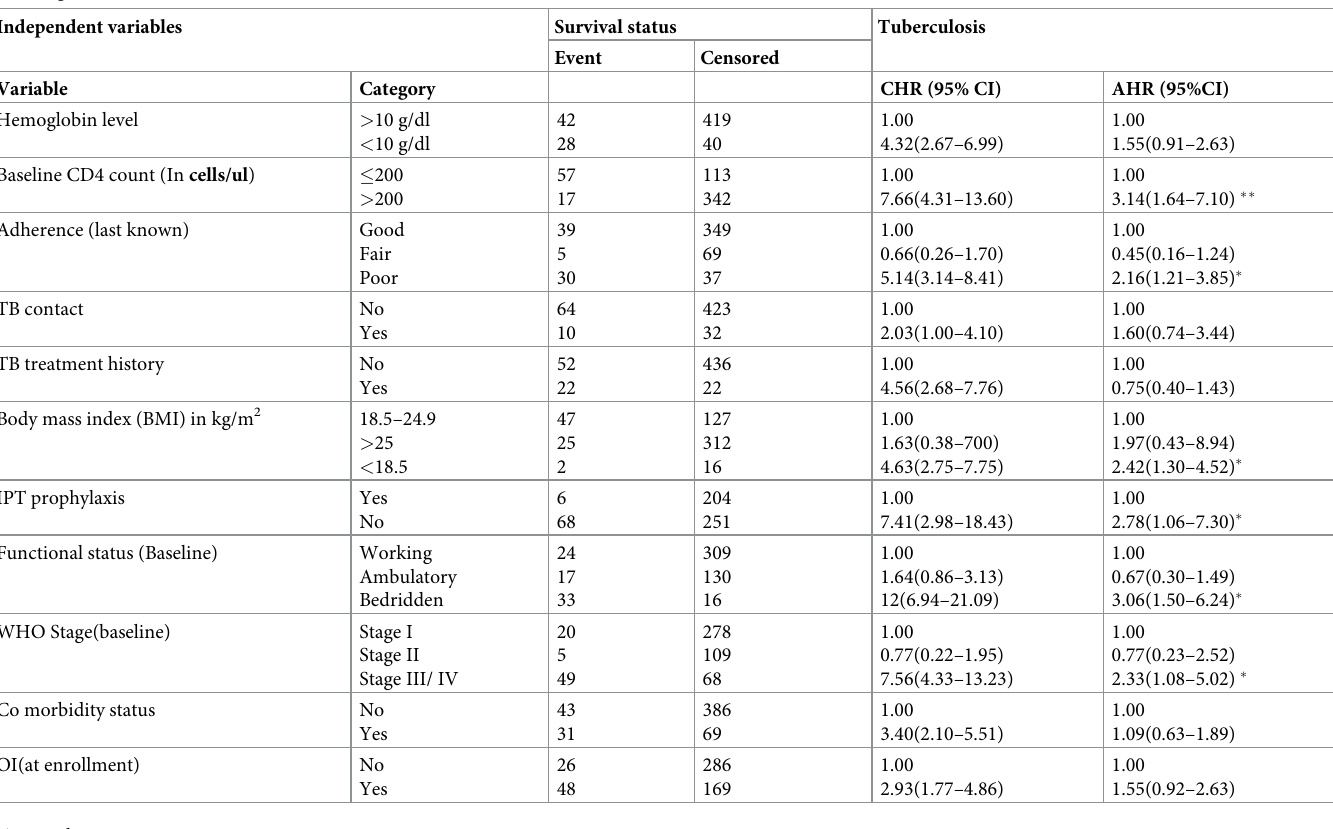
Table 3. Predictors of Tuberculosis among Adult HIV patients on ART at St. peter specialized hospital and Zewditu memorial Hospital between January 1, 2016 and August 25,